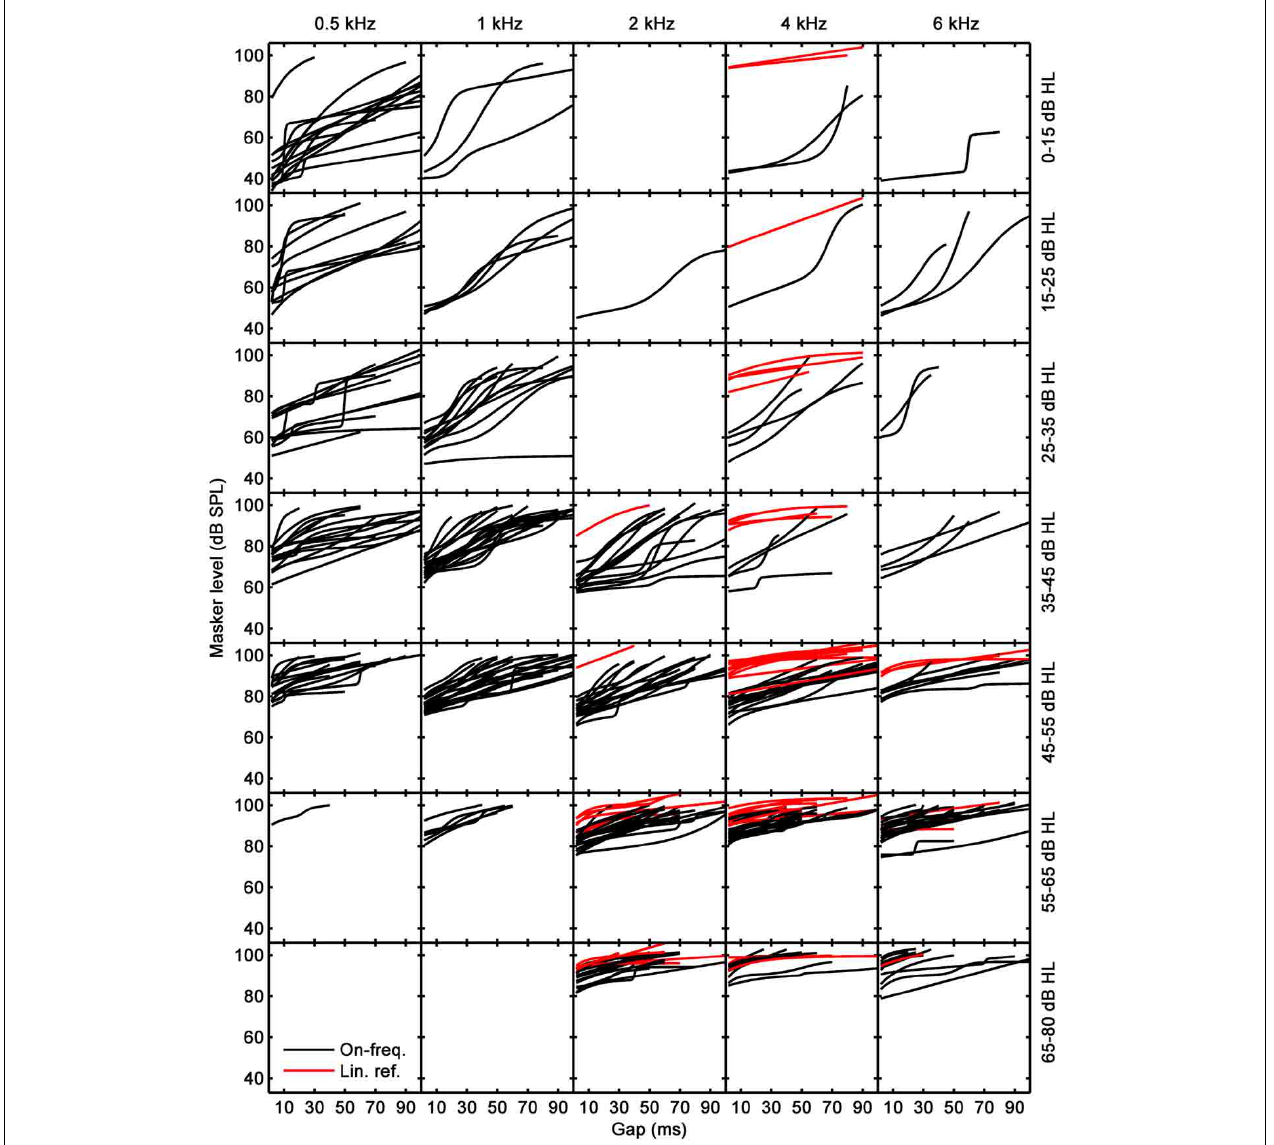
FIGURE 2 | Fitted linear-reference (red curves) and on-frequency TMCs (black curves). Each column corresponds to a different test frequency as indicated by the column title and each row to different a hearing-loss range, as indicated by the text on the right-most